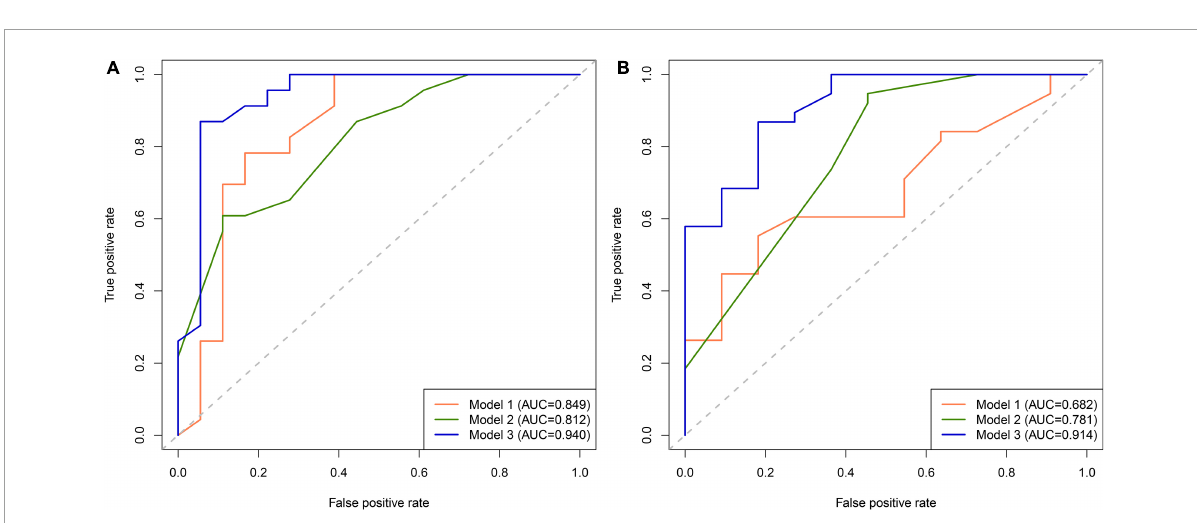
FIGURE3 Receiver operating characteristic (ROC) curve for PSCI nomogram. (A) Development cohort; (B) validation